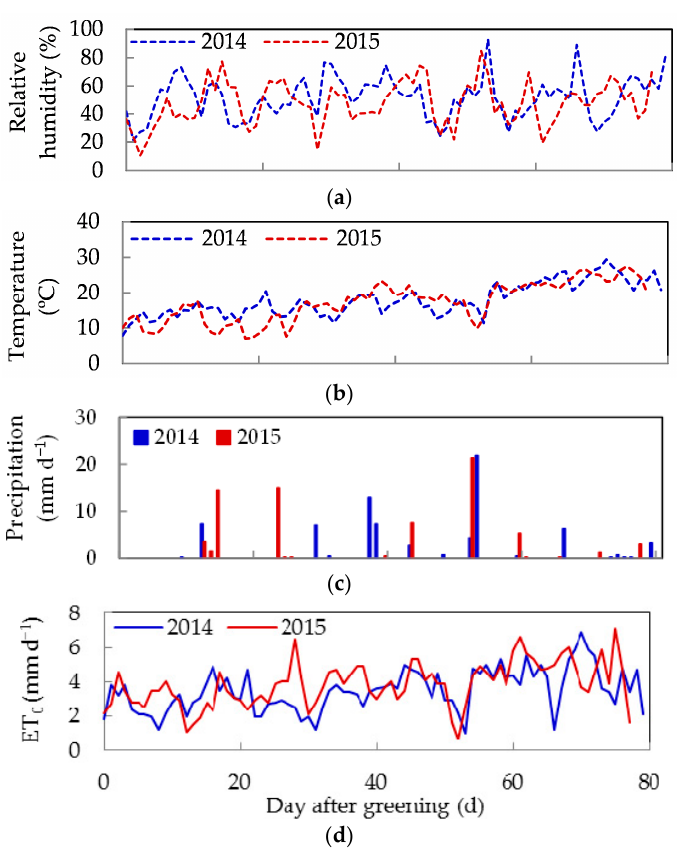
Figure 2. Temporal variation of ( a ) mean air temperature, ( b ) relative humidity, ( c ) precipitation, and ( d ) reference evapotranspiration (ET 0 ) throughout greening to harvest growing season for winter wheat in 2014 and 2015.